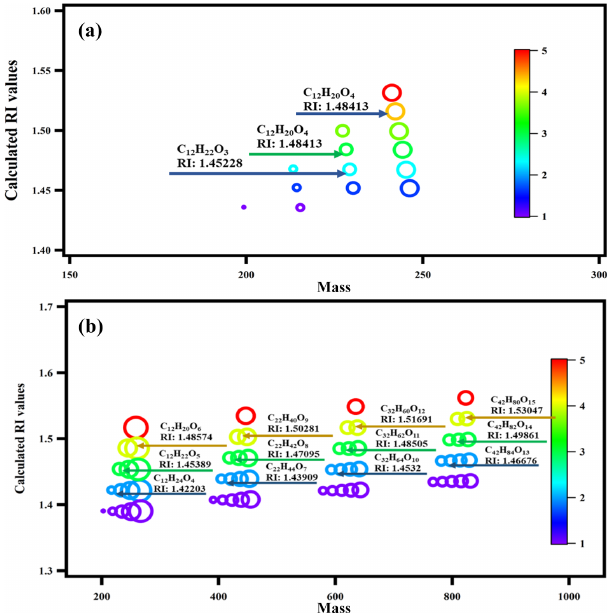
Figure 6. Calculated RI values of the surrogate system: (a) furan derivatives via intramolecular reaction, and (b) the oligomers via the formation of peroxyhemiacetal. The color map refers to the un- saturation of the molecular formula. The size of the circles indicates the size of the O / C